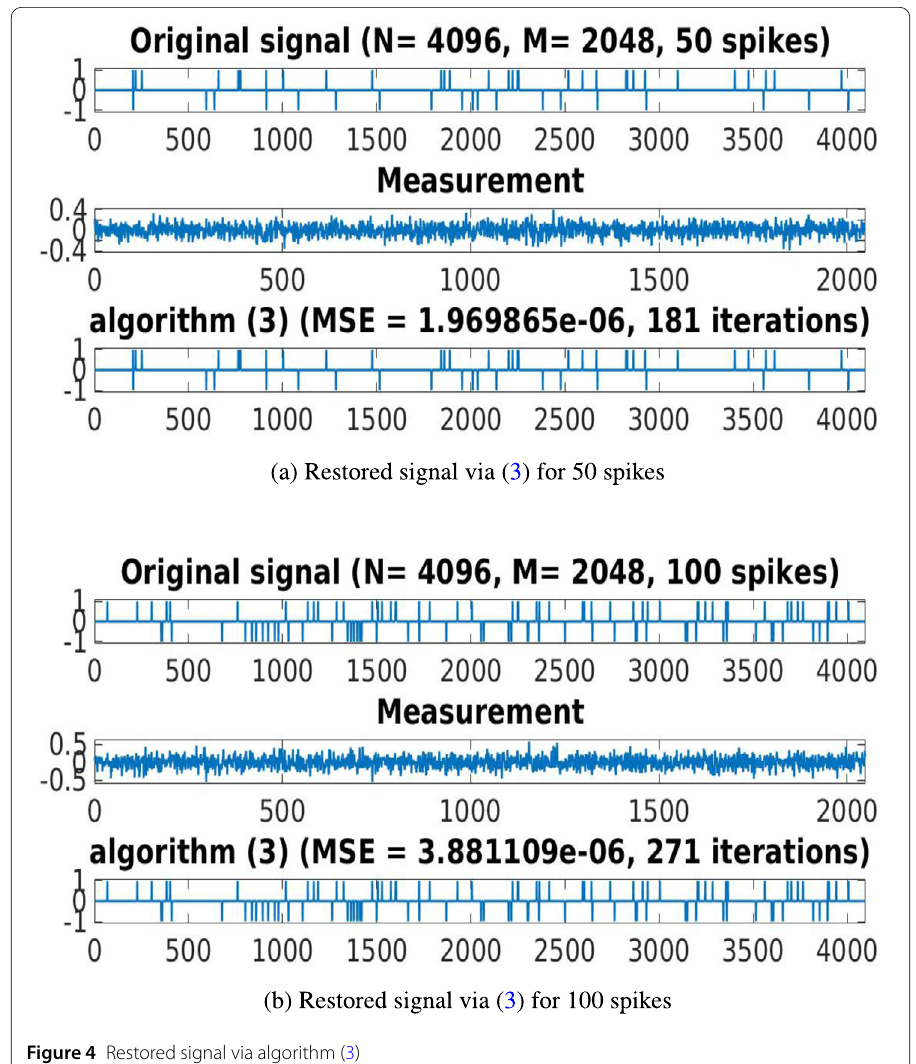
Figure 4 Restored signal via algorithm